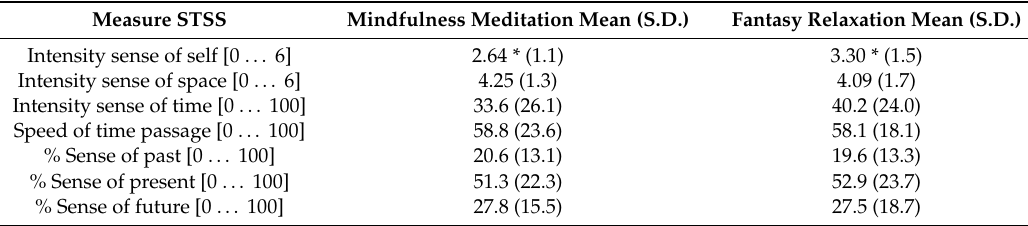
Table 1. Mean (S.D.) values for the conscious-state inventory on subjective time, self, and space (STSS) for the mindfulness meditation and the fantasy-relaxation intervention. Measure STSS Mindfulness Meditation Mean (S.D.) Fantasy Relaxation Mean (S.D.)